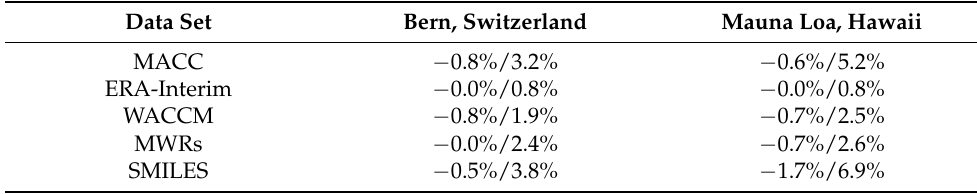
Table 2. Forming of the morning minimum and the afternoon maximum for a mean day of March from model systems and the Mauna Loa and Bern microwave radiometers (MWRs) (morning minimum/afternoon maximum in